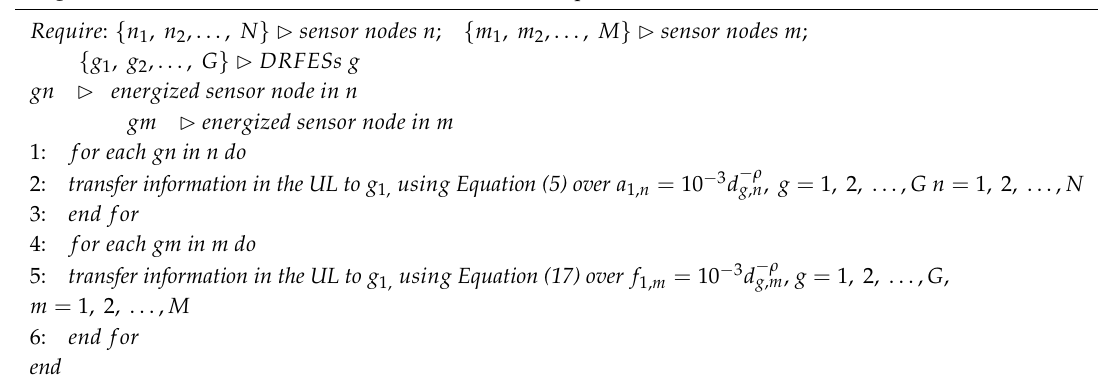
Algorithm 2. Efficient information transmission in the